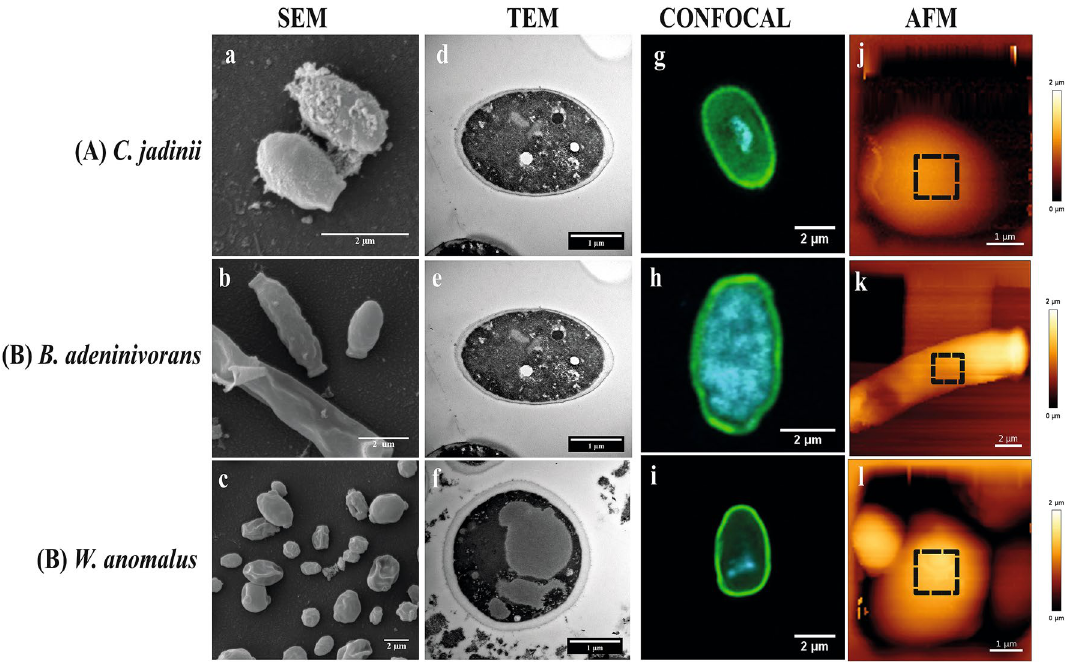
Figure 3. Cell surface architecture of three inactivated yeast species grown on sugars from lignocellulosic biomass. The pictures show Scanning Electron Microscopy ( SEM ; a – c ), Transmission Electron Microscopy ( TEM ; d – f ), Confocal microscopy (stained with concanavalin A-FITC for mannan) ( g – i ) and Atomic Force Microscopy ( AFM ; height) ( j – l ) micrographs of Cyberlindnera jadinii ( panel A ), Blastobotrys adeninivorans ( panel B ) and Wickerhamomyces anomalus ( panel C ). The SEM and TEM micrographs were taken on yeast creams (before drying), whereas the confocal and AFM micrographs were taken on dried yeast samples, as described in the ‘Material and Methods’. The dotted squares on the AFM height micrographs represent the spots where mapping was done for determination of the Young modulus and measurement of adhesion events, as described in ‘Material and